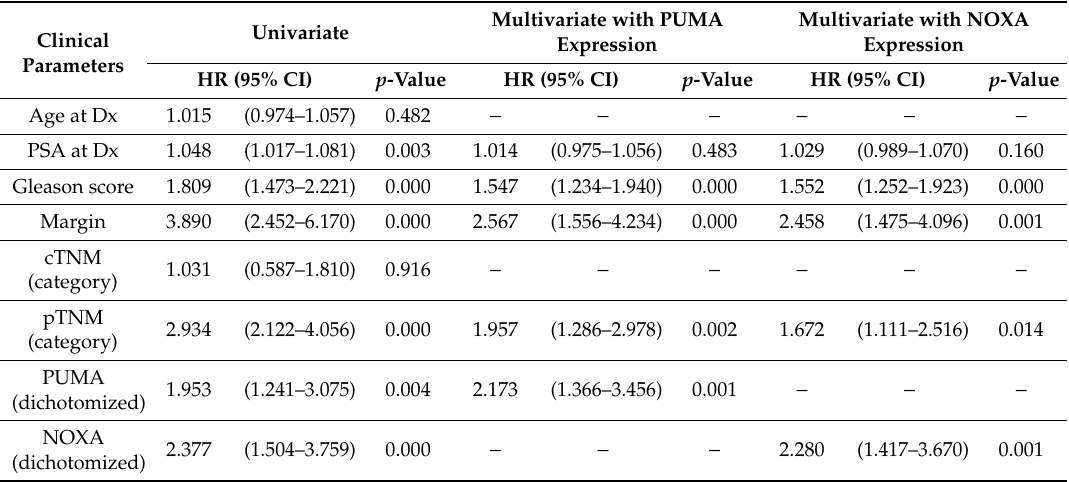
Table 2. Univariate and multivariate Cox regression analyses of clinical parameters and PUMA / NOXA biomarker expression in benign epithelial cells to predict biochemical recurrence at 3